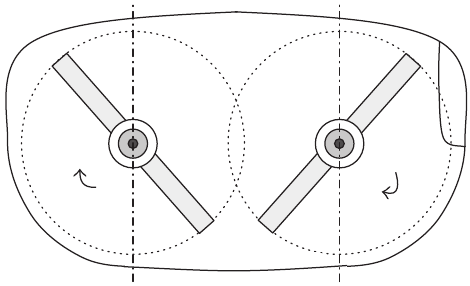
Figure 2: Schematic diagram of mower deck Model II.